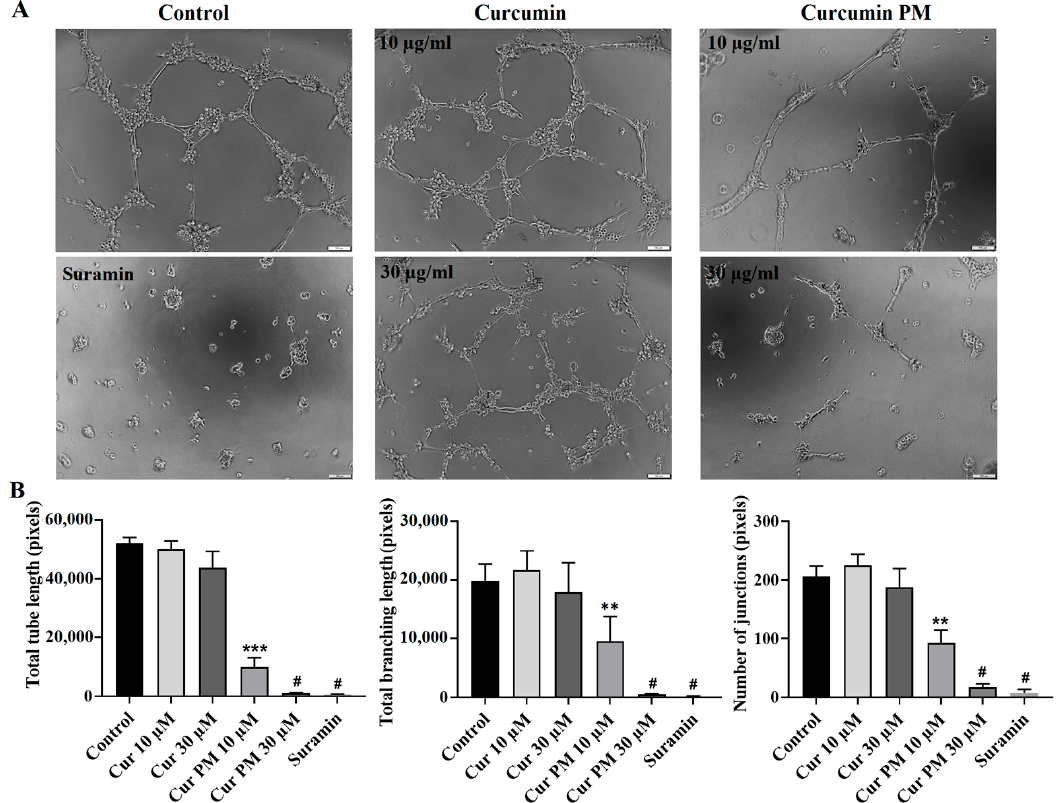
Figure 5. The effect of curcumin PM on the tube formation of hUVECs. ( A ) The morphology of tube- like structures in those cells incubated with free curcumin and curcumin PM at two concentrations of 10 and 30 µg/mL. ( B ) Quantitative analysis of tube formation ability in hUVECs under different culture conditions. The data are presented as mean ± SD, N = 3. ** p < 0.01; *** p < 0.001; # p < 0.0001. Cur: curcumin; Cur PM: curcumin PM. Scale bar: 50 µm.